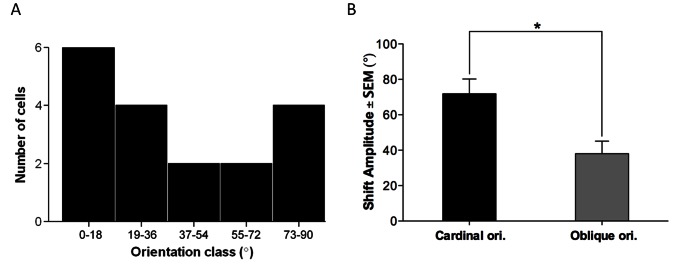
Distribution of orientation-class preference and shift magnitude significance.(A) Neurons divided into five orientation classes of 18°. Vertical and horizontal orientations dominate (that is cardinal orientations). (B) The relationship between shift-magnitude and significance level indicates that cardinal orientations have larger shift than cells whose orientation is oblique.